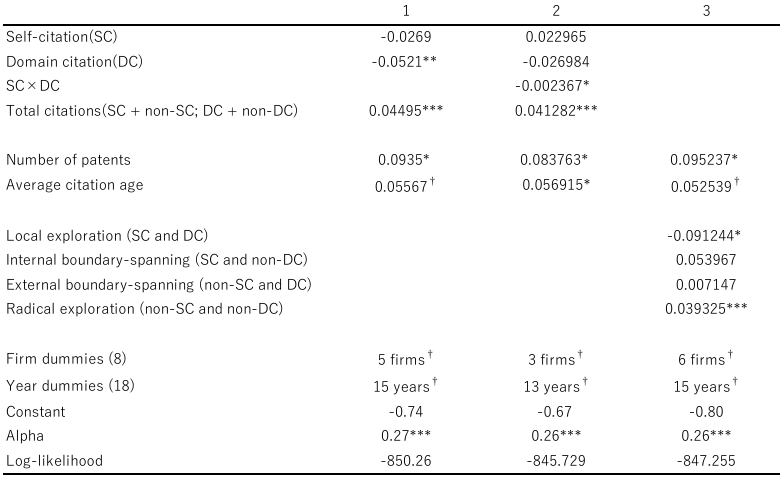
Table 5. Negative binomial regression on outside impact ( n =